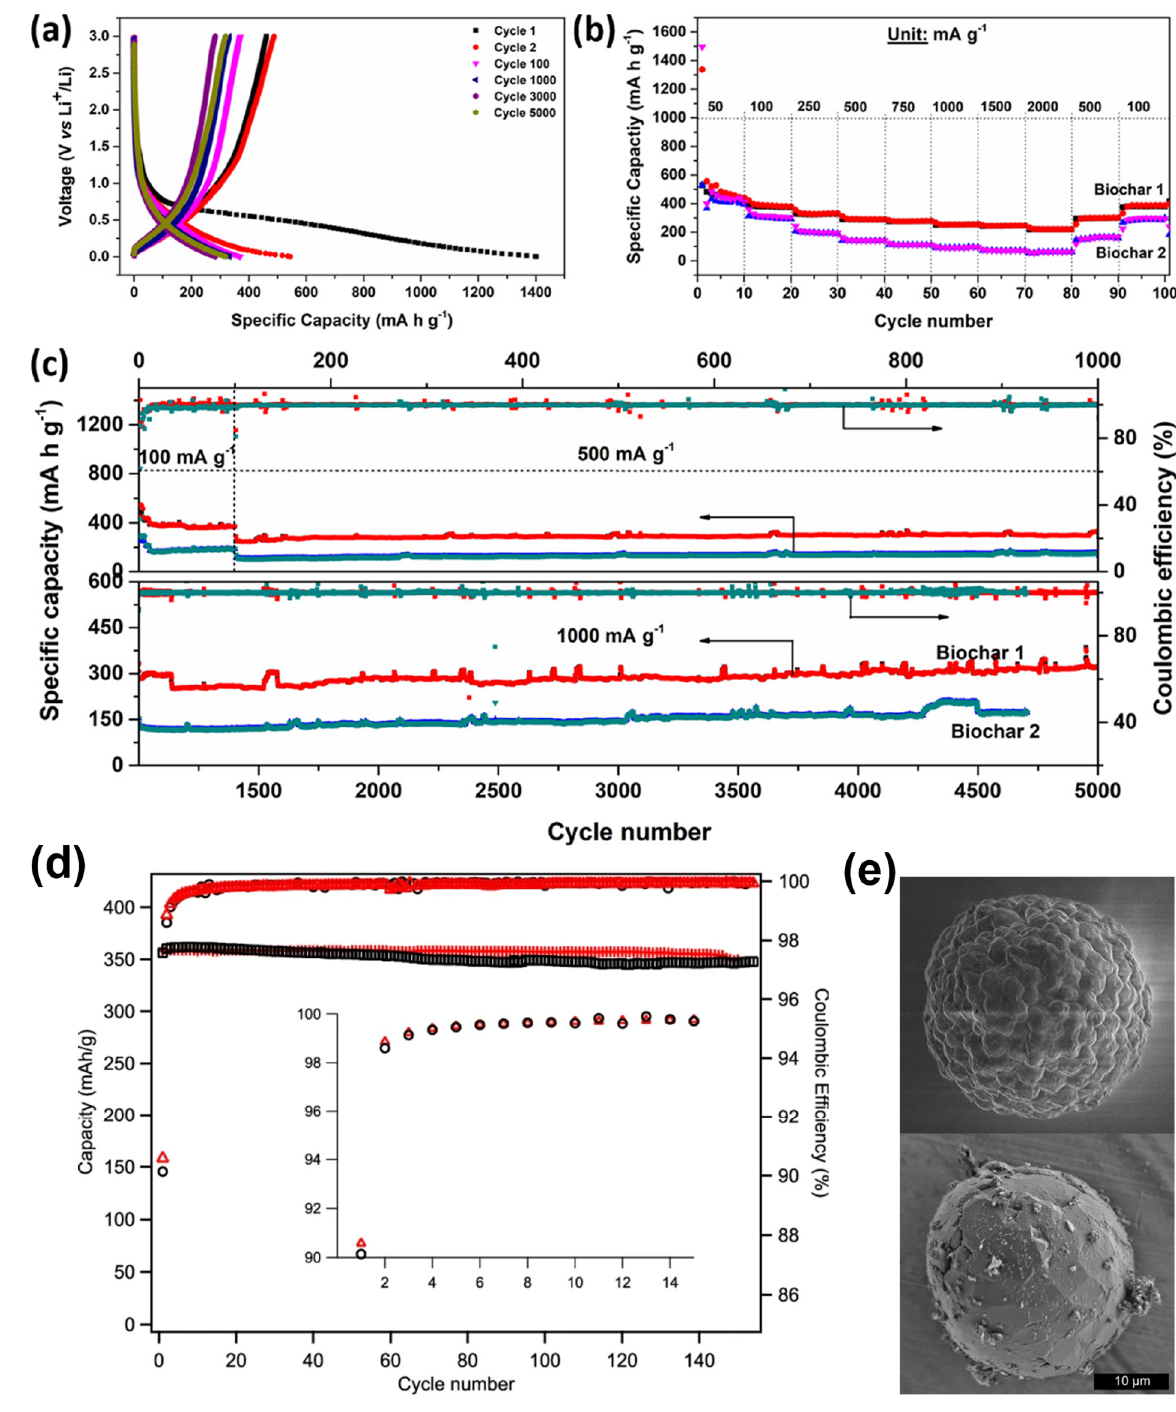
Figure 5. ( a ) Charge-discharge of biochar − 1 at various cycles; ( b ) rate capability and ( c ) long-cycling profiles of biochars at different current densities. Reproduced from [77] with permission from ACS. ( d ) The electrochemical performances of biomass carbon sBCG and MagE 3 (first 15 cycles of CE insect plots). ( e ) The morphology of raw spherical algae and BCG. The BCG is interconnected graphite fakes. Reproduced from [78] with permission from Springer Nature.